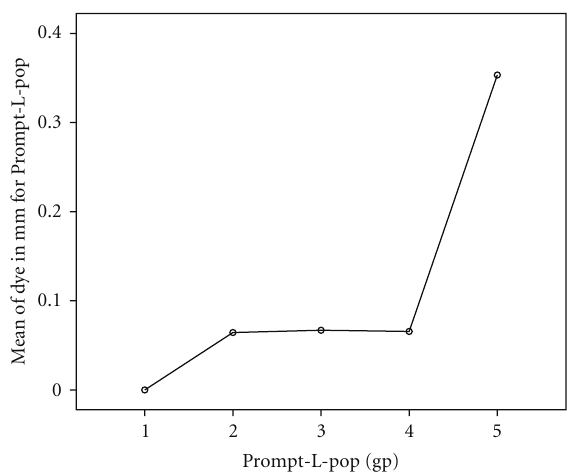
Figure 3: Result of Bonferroni test for the di ff erence between cavity configuration groups for Prompt-L-Pop self-etch bonding agent.